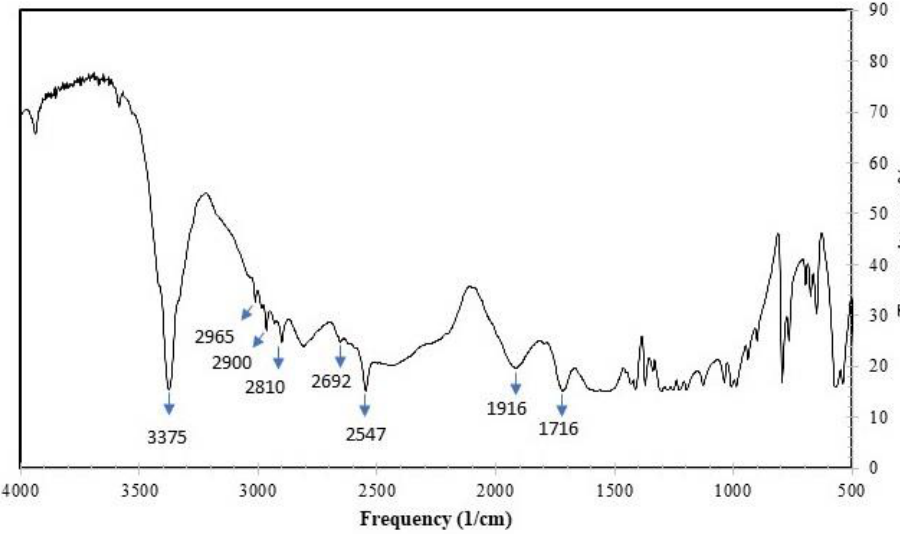
Figure 4. FT-IR spectrum of purified N -acetylcysteine molecule.